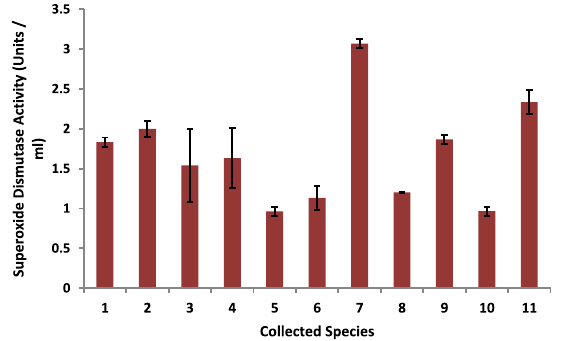
Fig. 3 Superoxide dismutase activity